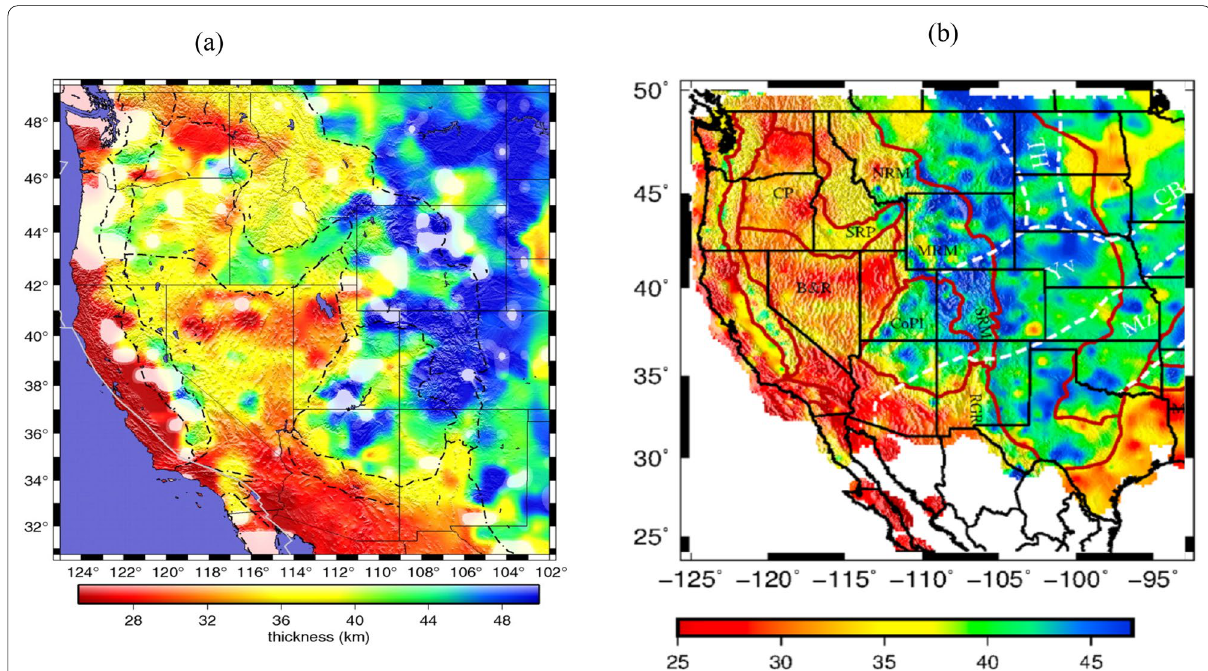
Fig. 13 Estimated Moho depth of the study area sing seismic data: a Gilbert (2012) and b Ma and Lowry